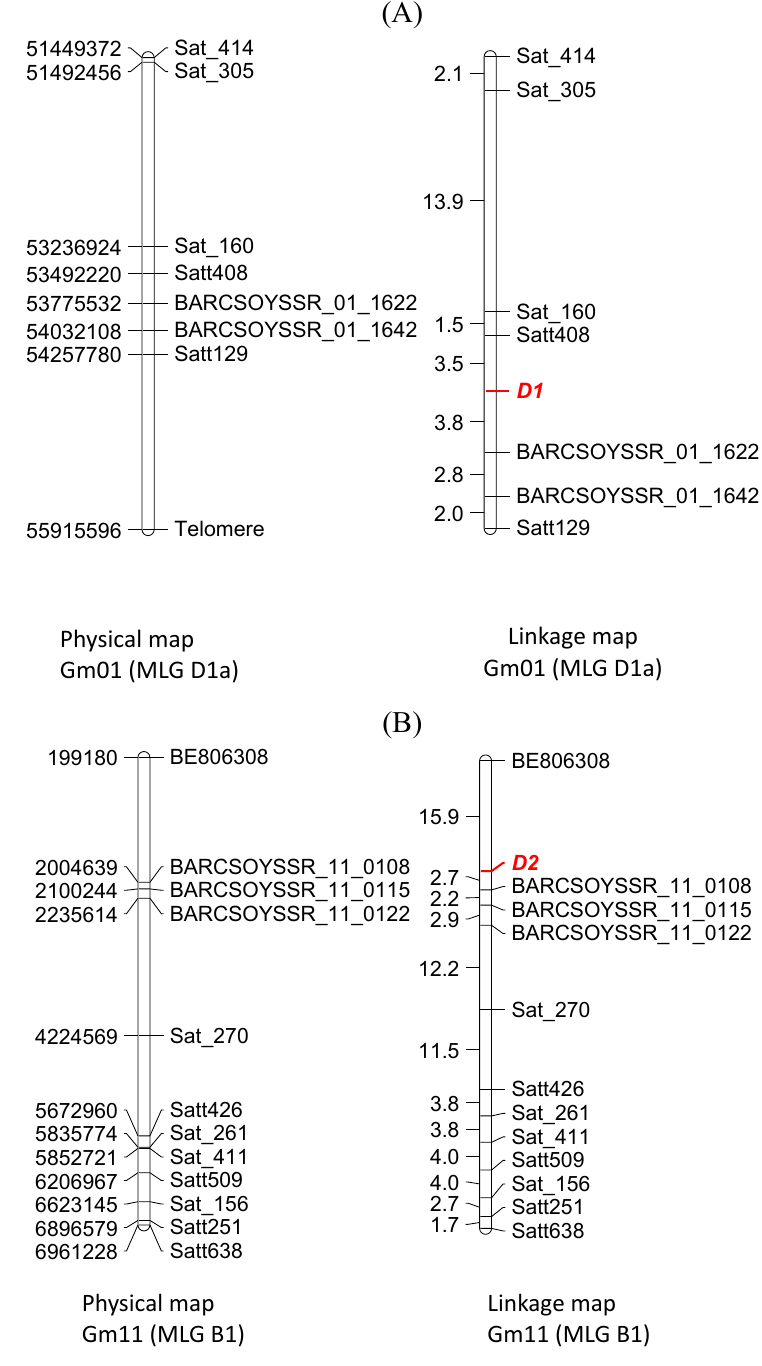
Figure 3. Genetic linkage mapping of cotyledon color genes from the cross Minsoy ( D D D D ; PI 27890) × Harosoy ( d 1 1 2 2